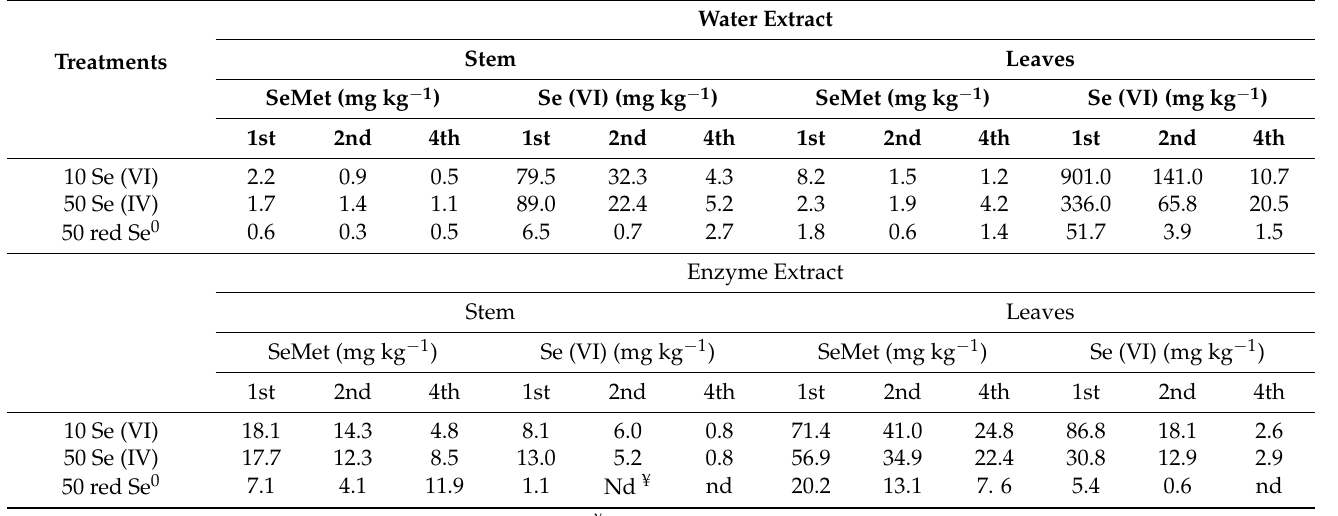
Table 1. Selenomethionine (SeMet) and selenate (Se (VI)) content in stem and leaves of alfalfa grown on different selenium (Se) forms and concentrations within three